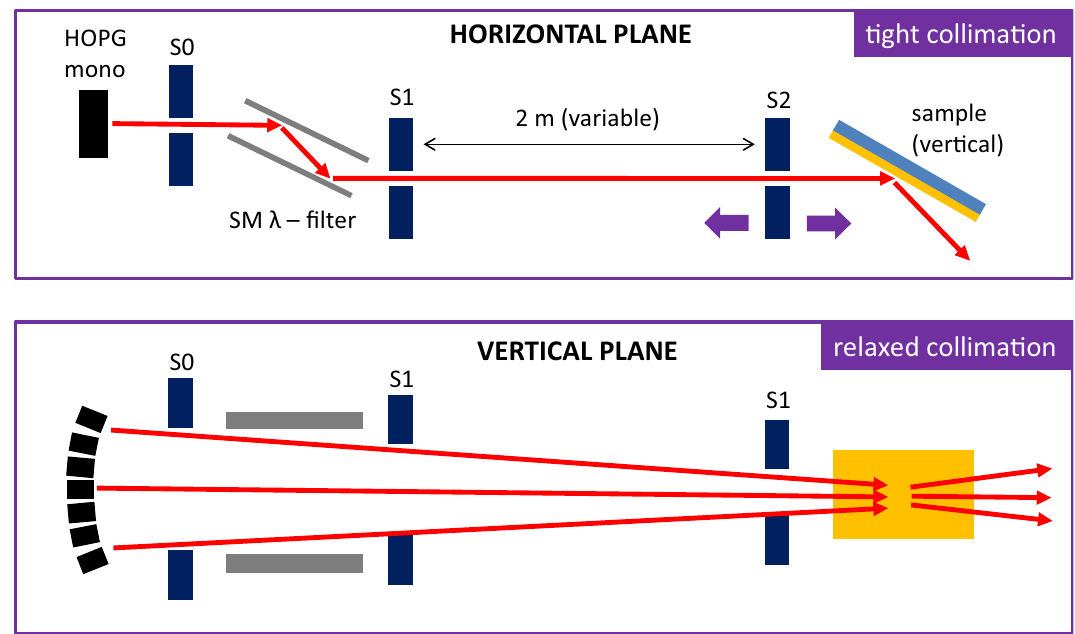
Figure 1. Sketch of the focusing and collimation systems of the instrument Super